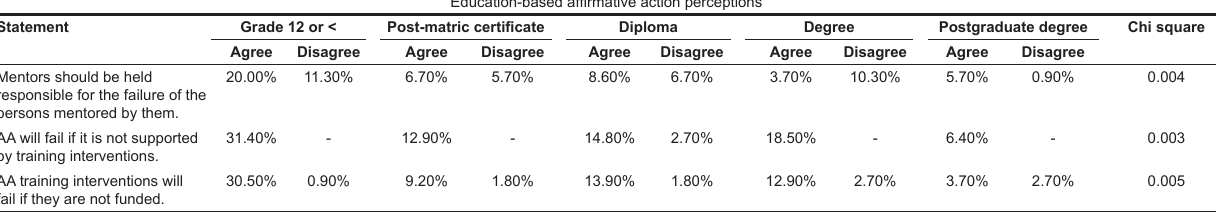
TABLE 2 Education-based affirmative action